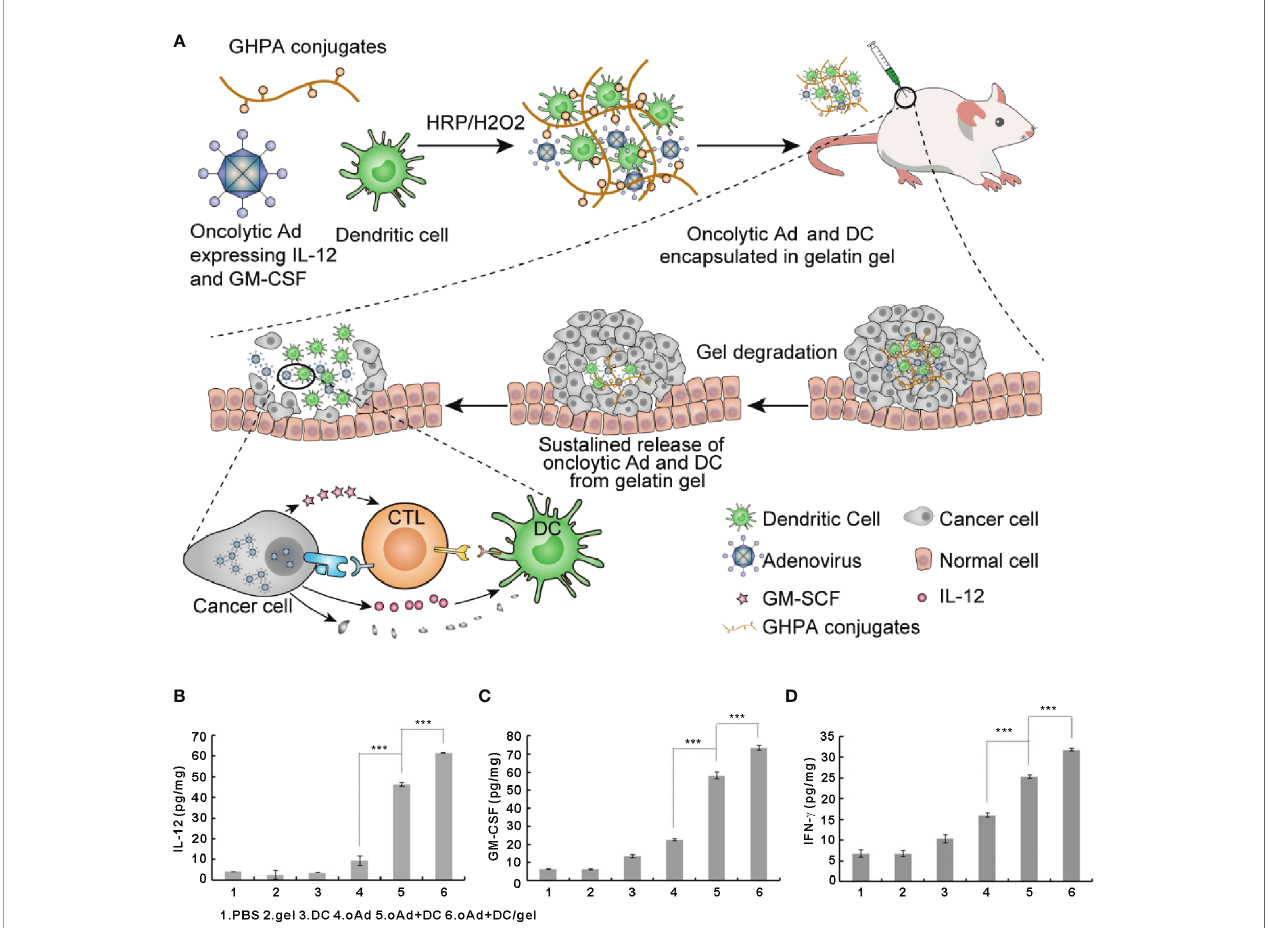
FIGURE 5 | Oncolytic adenoviruses and dendritic cells encapsulated in gelatin gels activate the immune system to eliminate tumor cells and induce the expression of IL-12 and GM-CSF in tumor cells. (A) Schematic representation of optimized biodegradable polymeric reservoir-mediated local and sustained co-delivery of dendritic cells and oncolytic adenovirus expressing IL-12 and GM-CSF. (B – D) The expression levels of IL-12 (B) , GM-CSF (C) , and IFN- g (D) in tumors. Reprinted with permission from Elsevier (116). ***P <